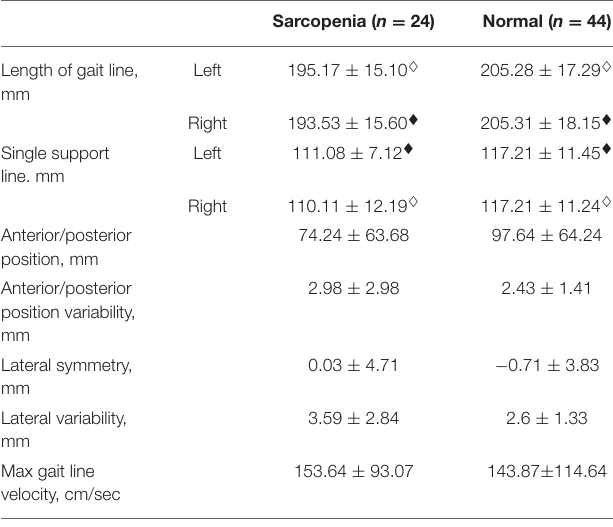
TABLE 3 | Butterfly parameters of the